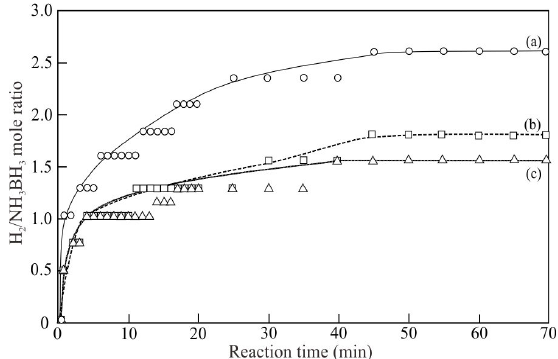
Fig. 7 H 2 /NH 3 BH 3 molar ratios of hydrogen generated from an aqueous NH 3 BH 3 solution (0.14 wt%, 3.5 mL) in the presence of the hollow silica  alumina composite spheres prepared using (a) 40, (b) 80, and (c) 120 g of the PS suspension.